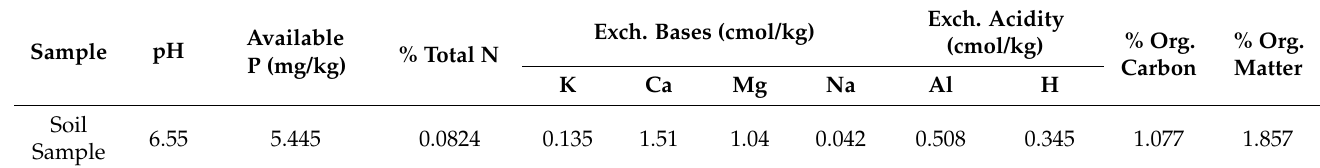
Table 18. Chemical analysis of soil used in the screen-house experiment.